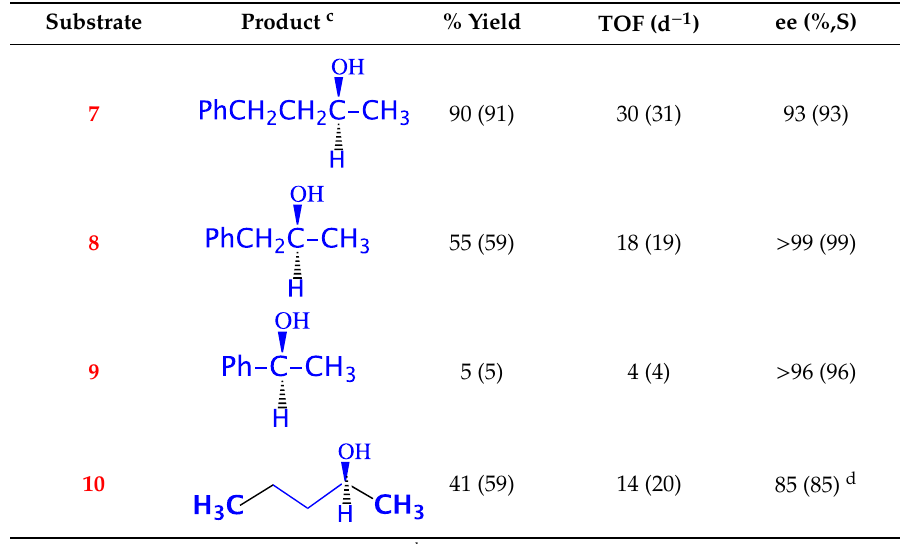
Table 1. Enzymatic Reductions of Achiral Ketones with NAD + Models 1 and 2 : Turnover Frequencies and Enantiomeric Excess. a,b